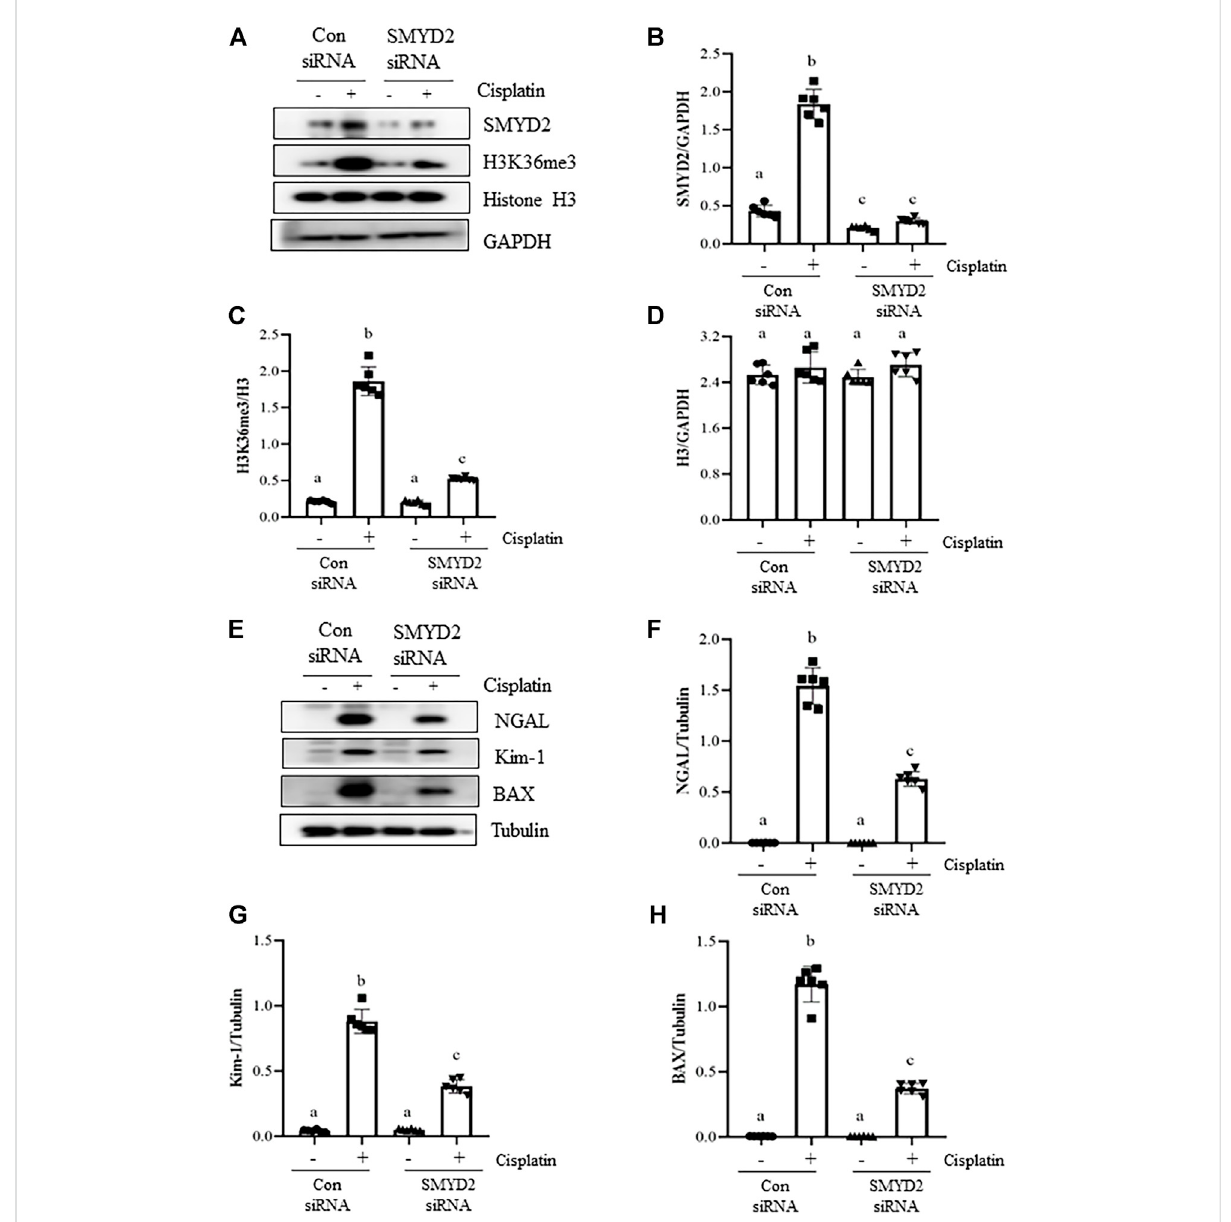
SilencingofSMYD2byspeci fi csiRNAinhibitscisplatin-inducedinjuryandapoptosisofkidneytubularcells invitro . (A) Celllysateswereprepared for immunoblot analysis with antibodies against SMYD2, H3K36me3, Histone H3 and GAPDH. (B – D) Expression levels of SMYD2 (B) , and Histone H3 (D) werequanti fi edbydensitometryandnormalizedwithGAPDH,along withH3K36me3 (C) normalized withHistone H3as indicated. (E) Cell lysates were prepared for immunoblot analysis with antibodies against NGAL, Kim-1, BAX and Tubulin. (F – H) Expression levels of NGAL (F) , Kim-1 (G) and BAX (H) were quanti fi ed by densitometry and normalized with Tubulin as indicated. Data are means ± S.E.M. ( n = 6). Means with different superscript letters are signi fi cantly different from one another ( p <